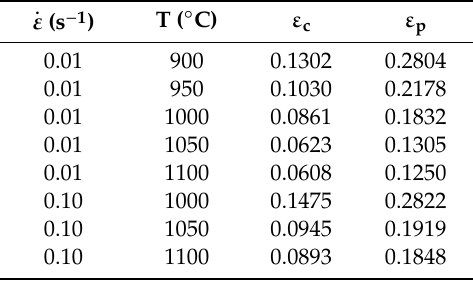
. ε = 0.1 s − 1 ). Table 3. Critical strain and peak